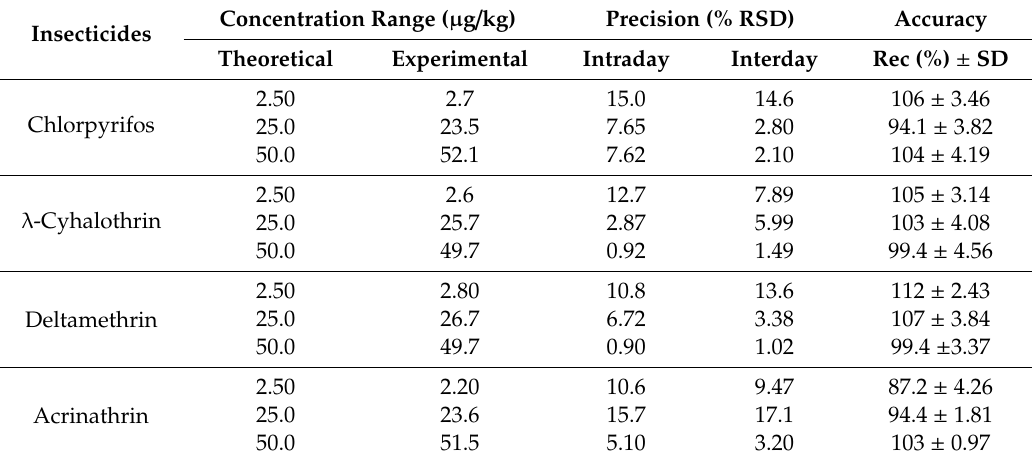
Table 3. Recovery and precision of insecticides in potatoes at three spiked levels.